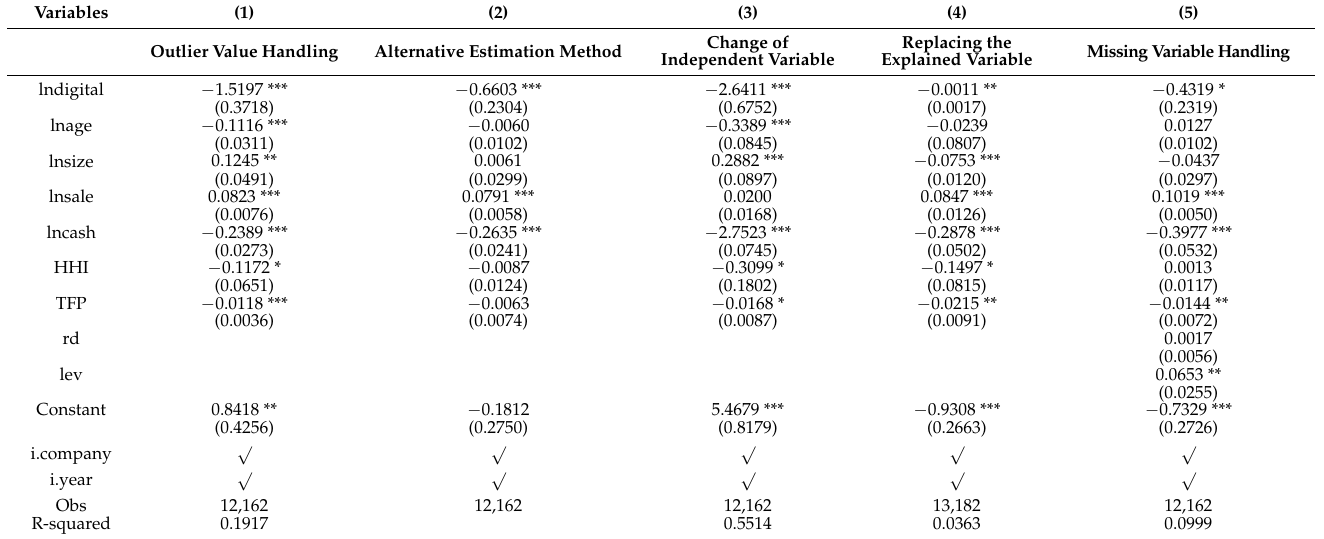
Table 4. Robustness